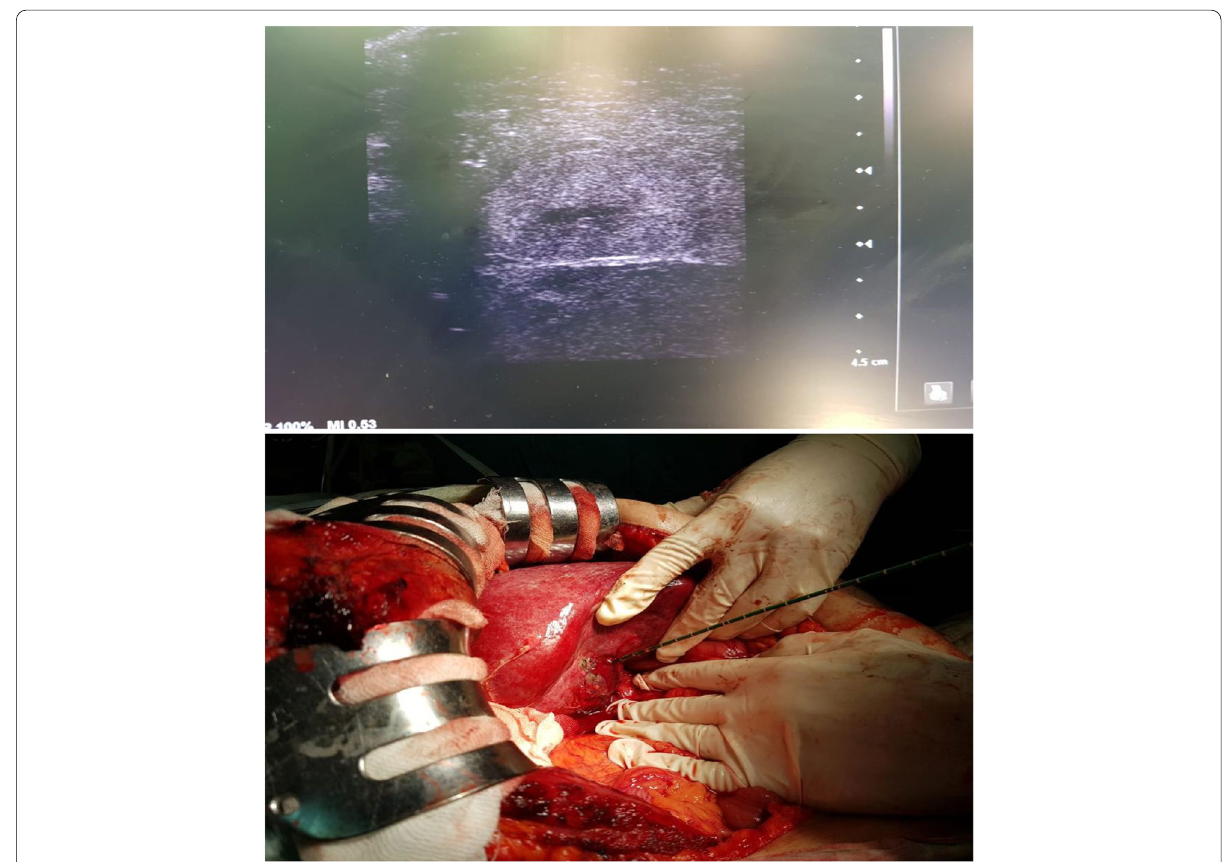
Fig. 3 Intraoperative MWA for a caudate lobe HCC under ultrasound guidance in one of the study